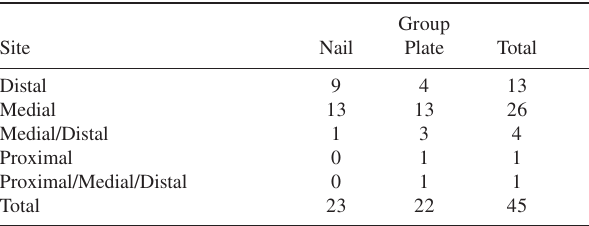
Table 3 - Distribution of patients by group and fracture site